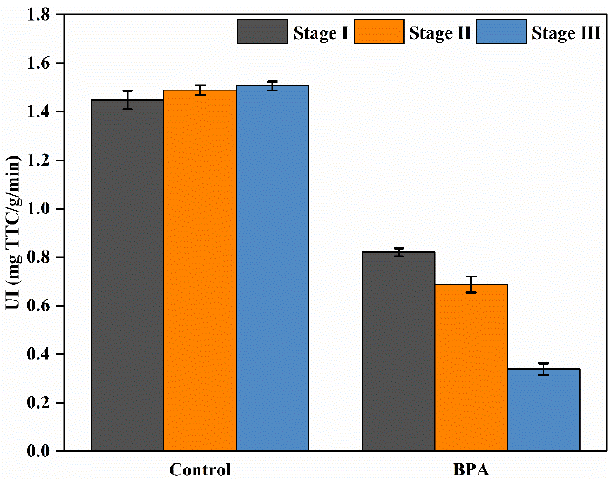
Figure 4. Effect of bisphenol A (BPA) on the dehydrogenase activity (DHA) of sequencing batch reactor (SBR) activated sludge.